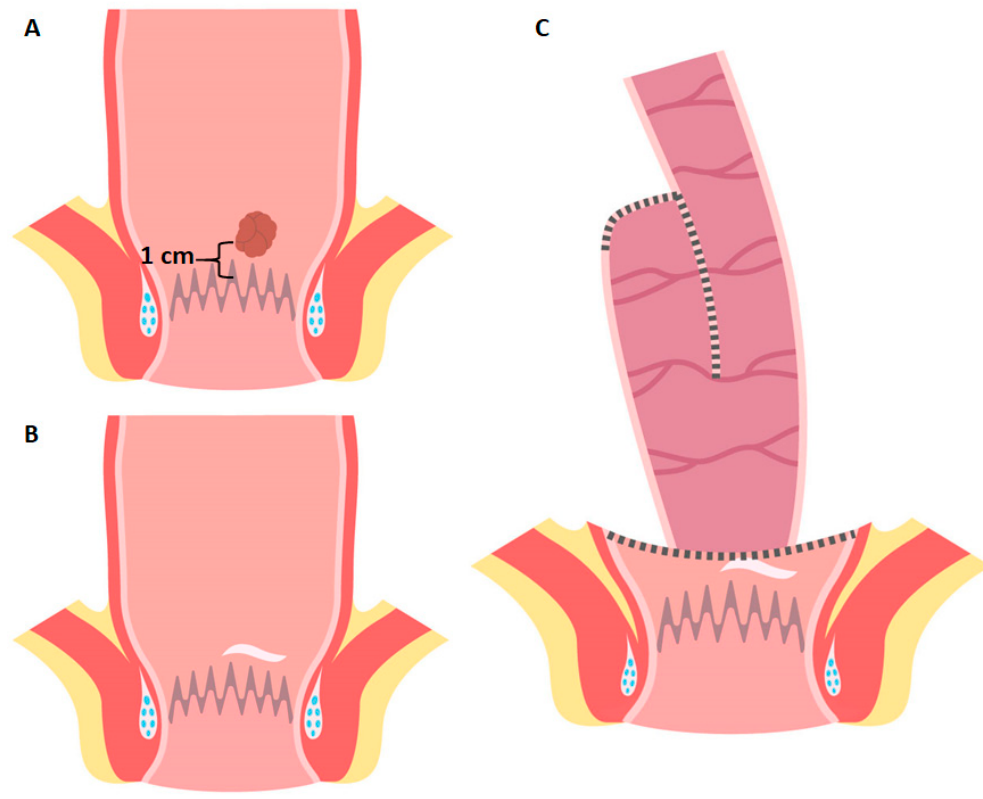
Figure 4. Local excision combined with stapled ileal pouch-anal anastomosis. ( A ) Schematic representation of low rectal cancer, less than 2 cm from the dentate line. ( B ) Residual rectum with local excision scar after first stage surgery. ( C ) Stapled IPAA on the residual rectal cuff at the level of the previous excision.